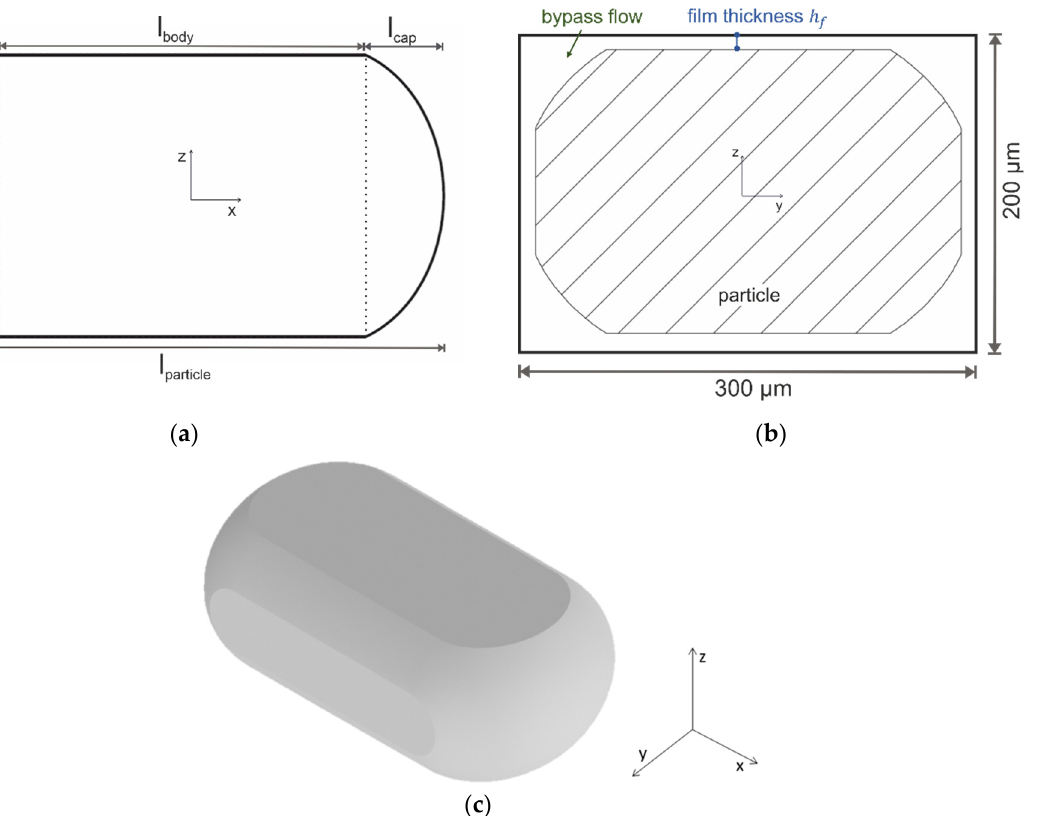
Figure 4. ( a ) Two-dimensional schematic drawing of a particle used for the simulations. ( b ) Cross- sectional drawing across the microfluidic channel. It can be seen that the particle does not stay in contact with the channel walls (due to the ionization of the walls), resulting in bypass and wall flow. ( c ) Three-dimensional presentation of the particle that was cut from the channel to do all the simulations.